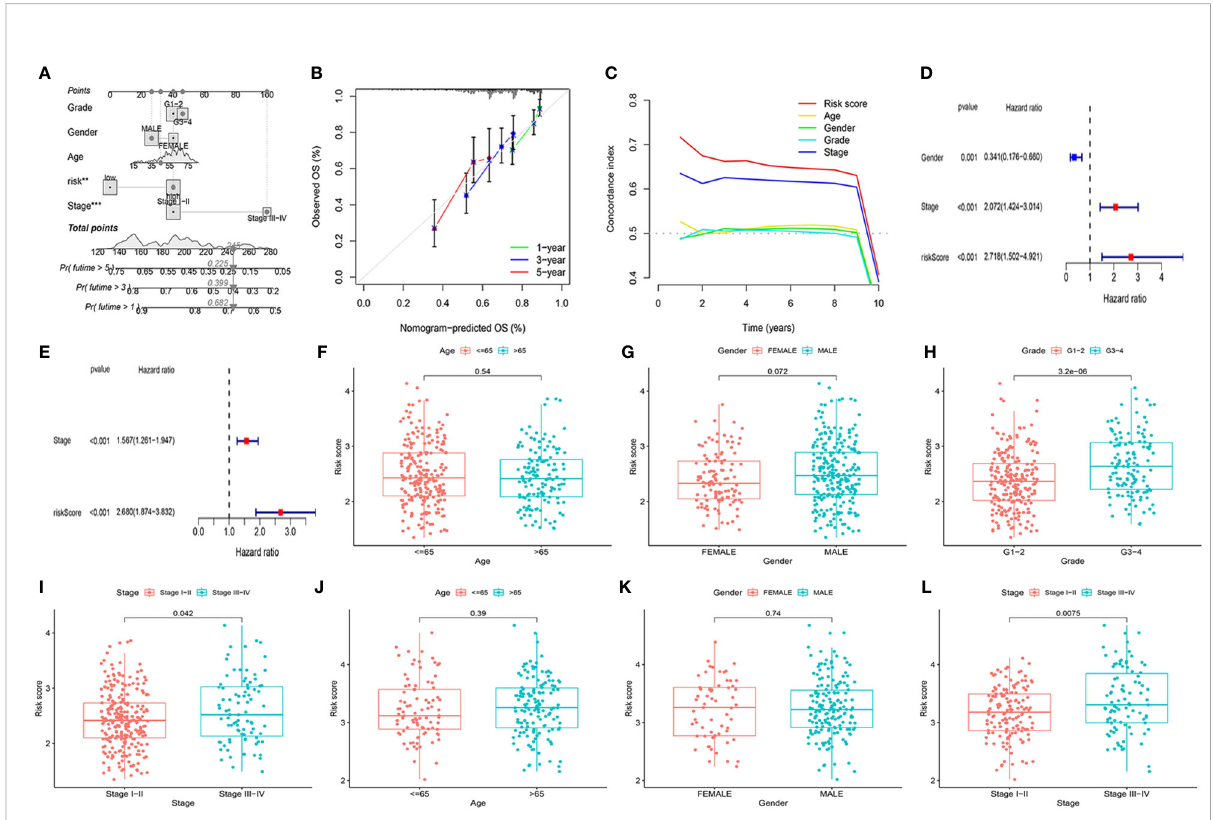
FIGURE 3 Evaluation of the prognostic signature and association of the risk score with clinicopathological characteristics. (A) Construction of a nomogram to predict the 1-year, 3-year, and 5-year survival probabilities based on OS-related pathological features. (B) The calibration curve was to verify the ef fi cacy of nomogram. (C) Evaluation the superiority of the risk score by the C-index. (D, E) Screening of OS-related pathological features by multivariate Cox regression in the TCGA and ICGC cohorts. TCGA cohort: (F) Age. (G) Gender. (H) Tumor grade. (I) Tumor stage. ICGC cohort: (J) Age. (K) Gender. (L) Tumor stage. **P<0.01,